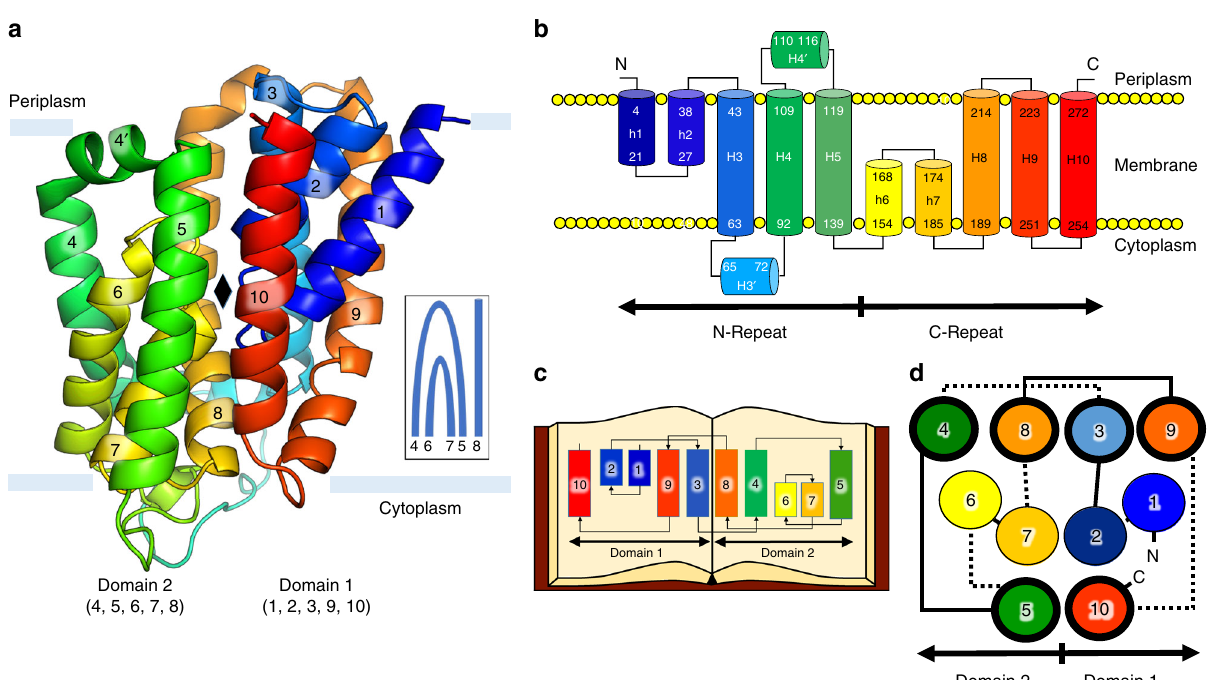
Fig. 3 Crystal structure and topology of BacA from E. coli . a View from the membrane plane. The protein has two domains related by a twofold axis in the plane of the membrane. Each domain consists of a double arch motif and a buttress helix. The double arch includes an outer arch formed by two transmembrane helices and an inner arch in the form of a re-entrant helical pair. A schematized version of domain 2 is included in the inset. The active site resides toward the mid-plane of the membrane at the core of the protein where the domains and the re-entrant helix loops approach one another. The structure is shown in cartoon representation and rainbow color coded from N-terminus (blue) to C-terminus (red). Approximate location of the membrane boundaries are shown in gray. The C 2 axis of pseudosymmetry is marked with a diamond. b Topology of BacA in a simpli fi ed representation to highlight the N-repeat and C-repeat as elements of symmetry in the protein. c Bringing together the two domains can be visualized by laying the folded topology on an open book. Closing the book brings the elements in the two domains into alignment generating the fully folded protein. d Schematic representation of the secondary structure elements in the BacA structure viewed from the periplasm. Circles and lines correspond to helices and loops, respectively. Solid lines are in or face the periplasm. Dashed lines are in or face the cytoplasm. The view shows how helices in the N-repeat (helices 1 – 5) and C-repeat (helices 6 – 10) interdigitate and combine to create domains with helices from both repeats. Color coding follows that in